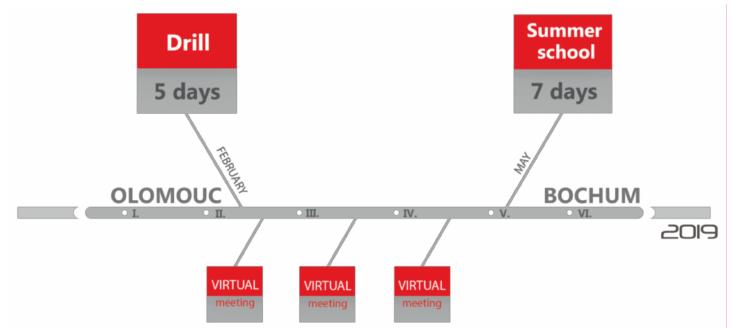
Figure 1. A timeline of the last year’s blended mobility of the Spationomy project in 2019. Source: